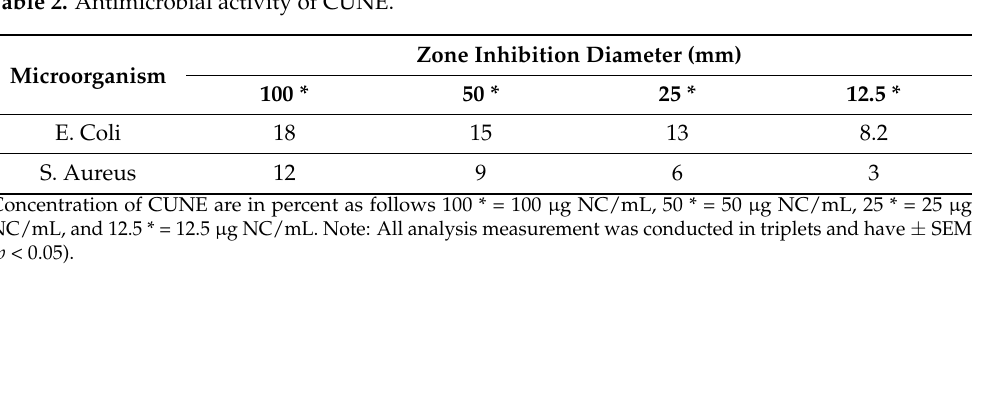
Table 2. Antimicrobial activity of